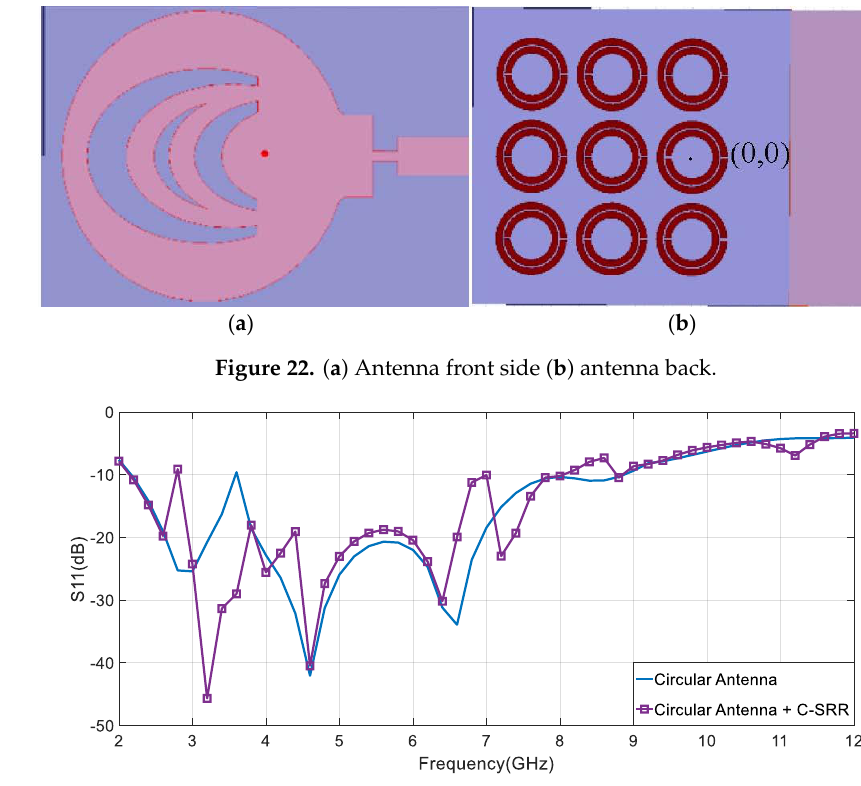
Figure 23. Simulated S 11 for circular antenna and the antenna with 3 × 3 C-SRR.